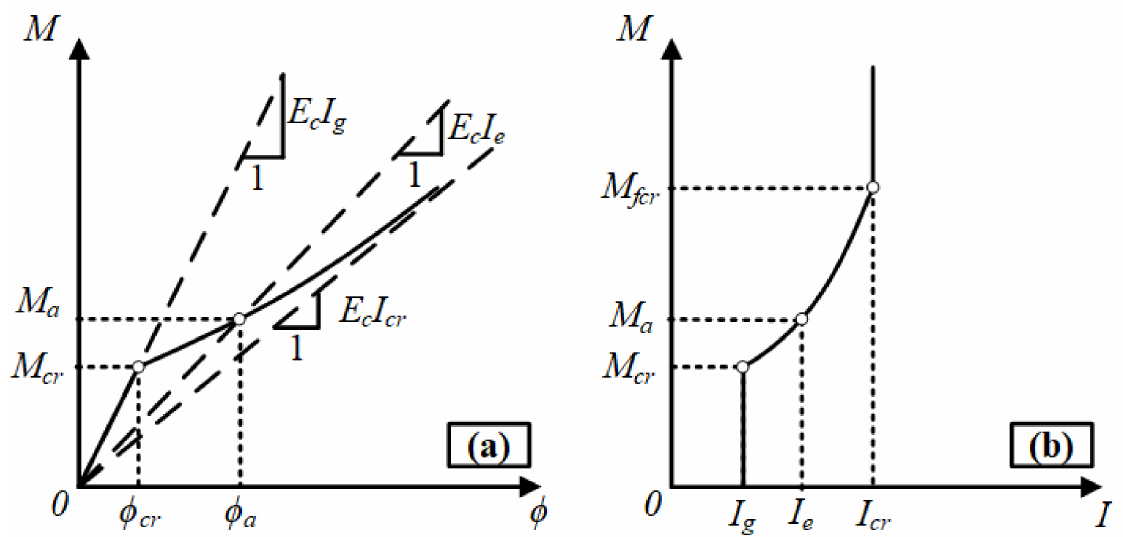
Figure 7. ( a ) Moment–curvature ( M – φ ) relationship of a typical RC beam with tension-controlled behavior [33]. ( b ) Variation of moment of inertia with applied moment for the same